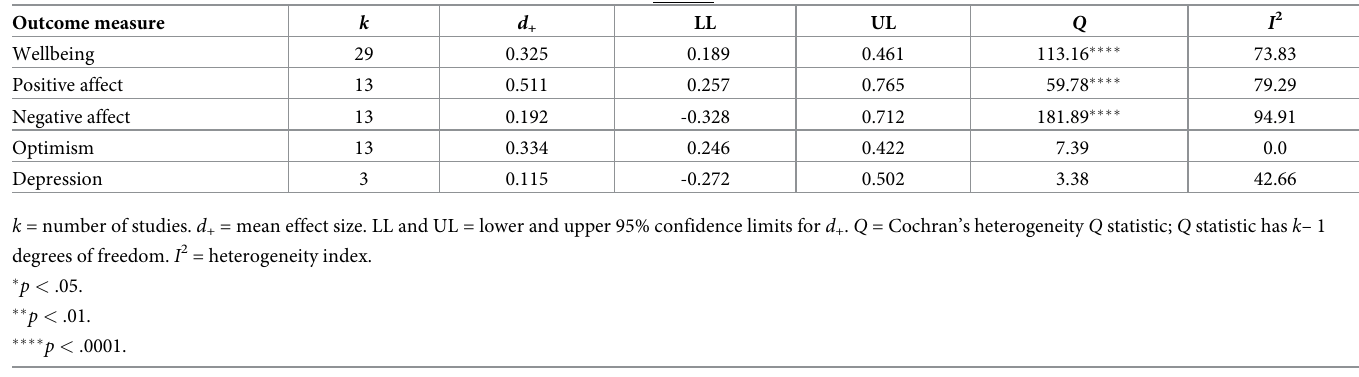
Table 3. Mean effect size, 95% confidence intervals, and heterogeneity statistics for the effectiveness of the BPS versus control group. Outcome measure k d +